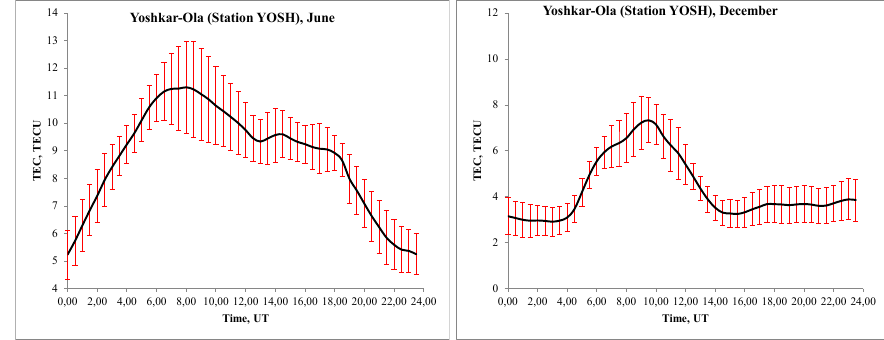
Fig. 2. TEC diurnal variations for the summer and winter